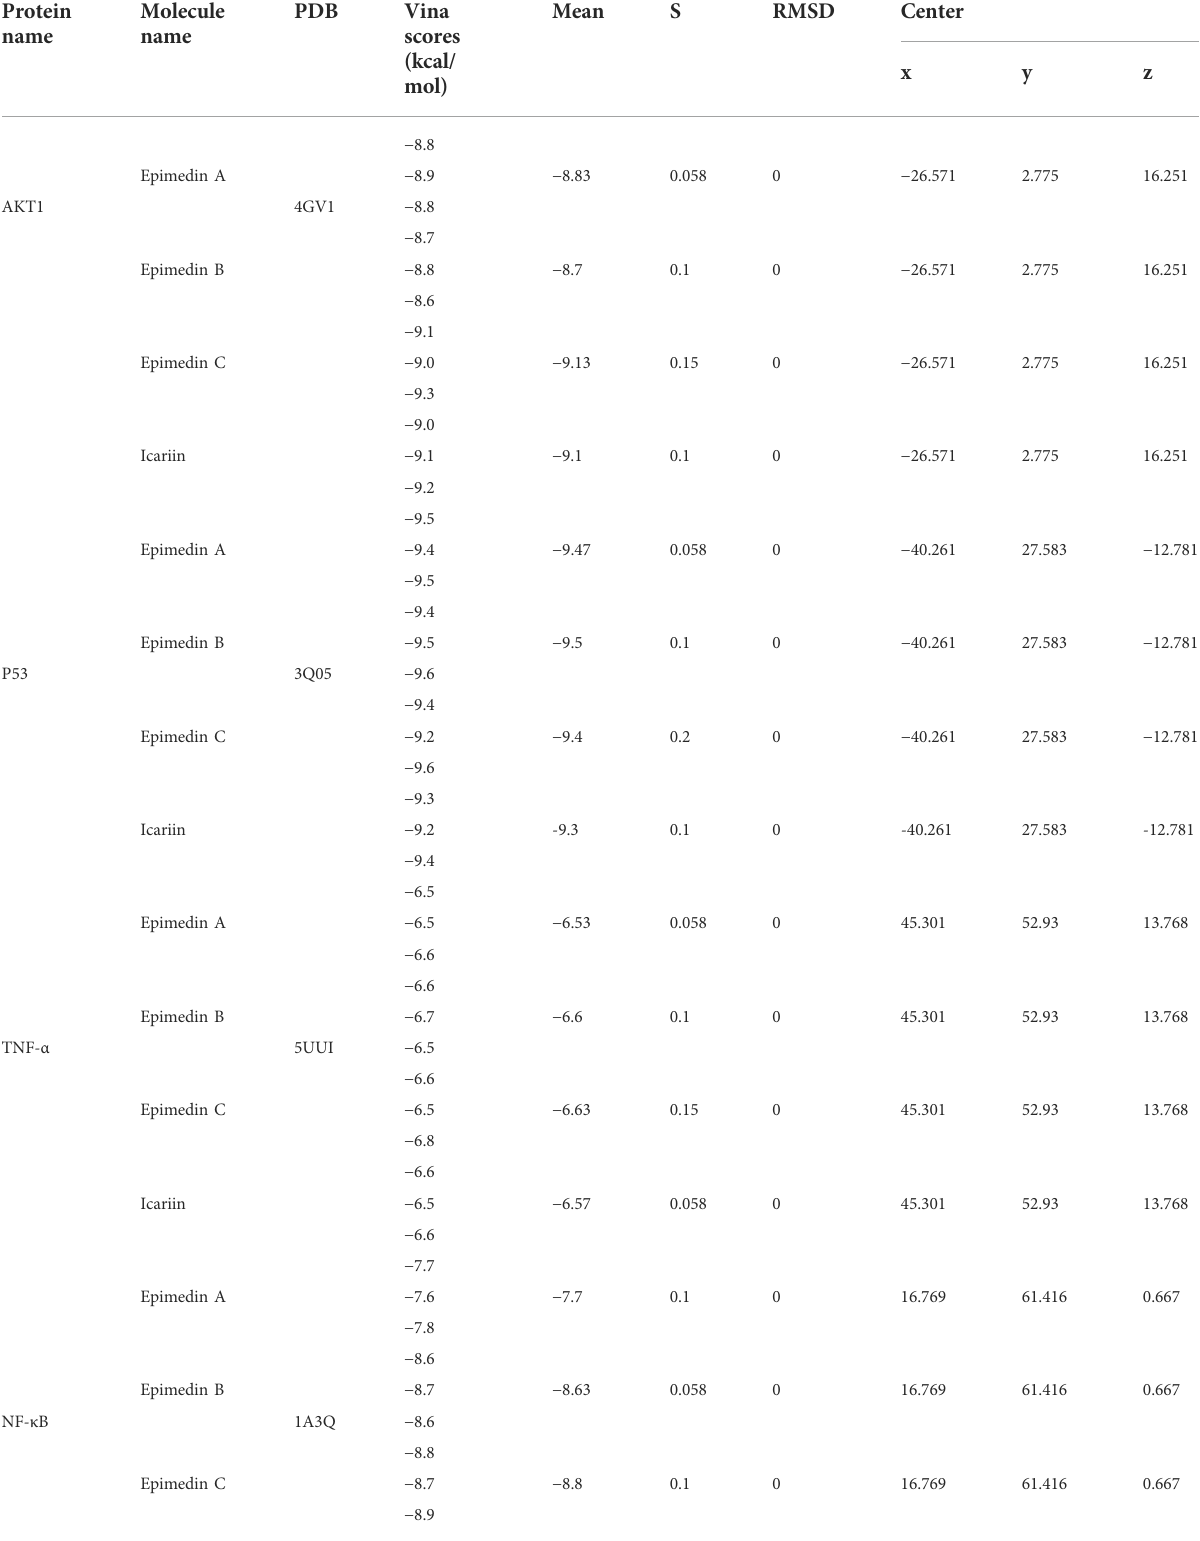
TABLE 2 Molecular docking results of core targets and active